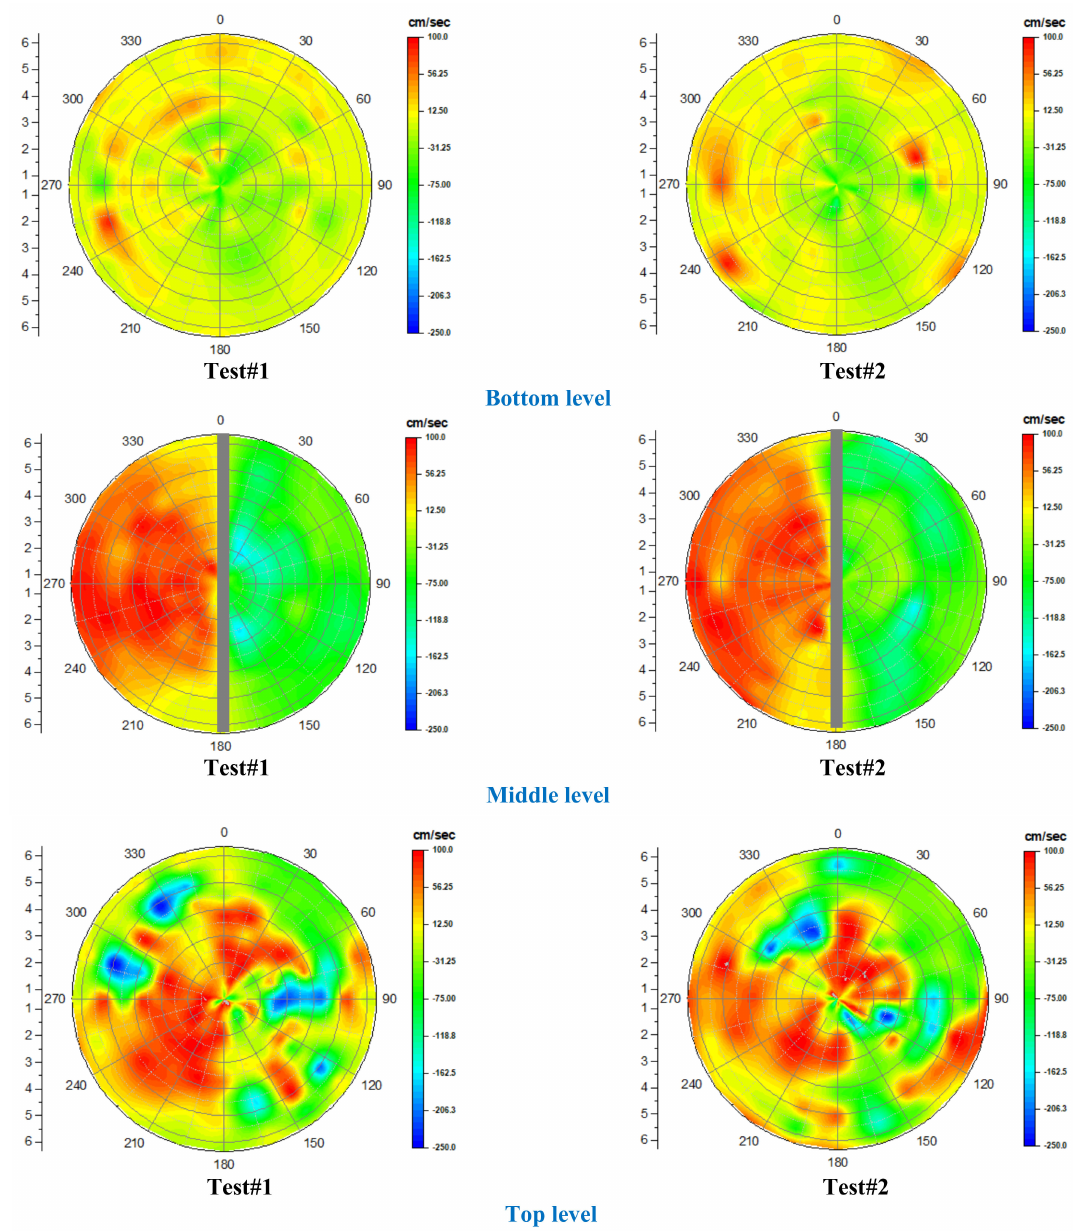
Figure 6. Reproducibility of the cross-sectional liquid velocity distributions in split reactor at all levels and operated gas velocity 3